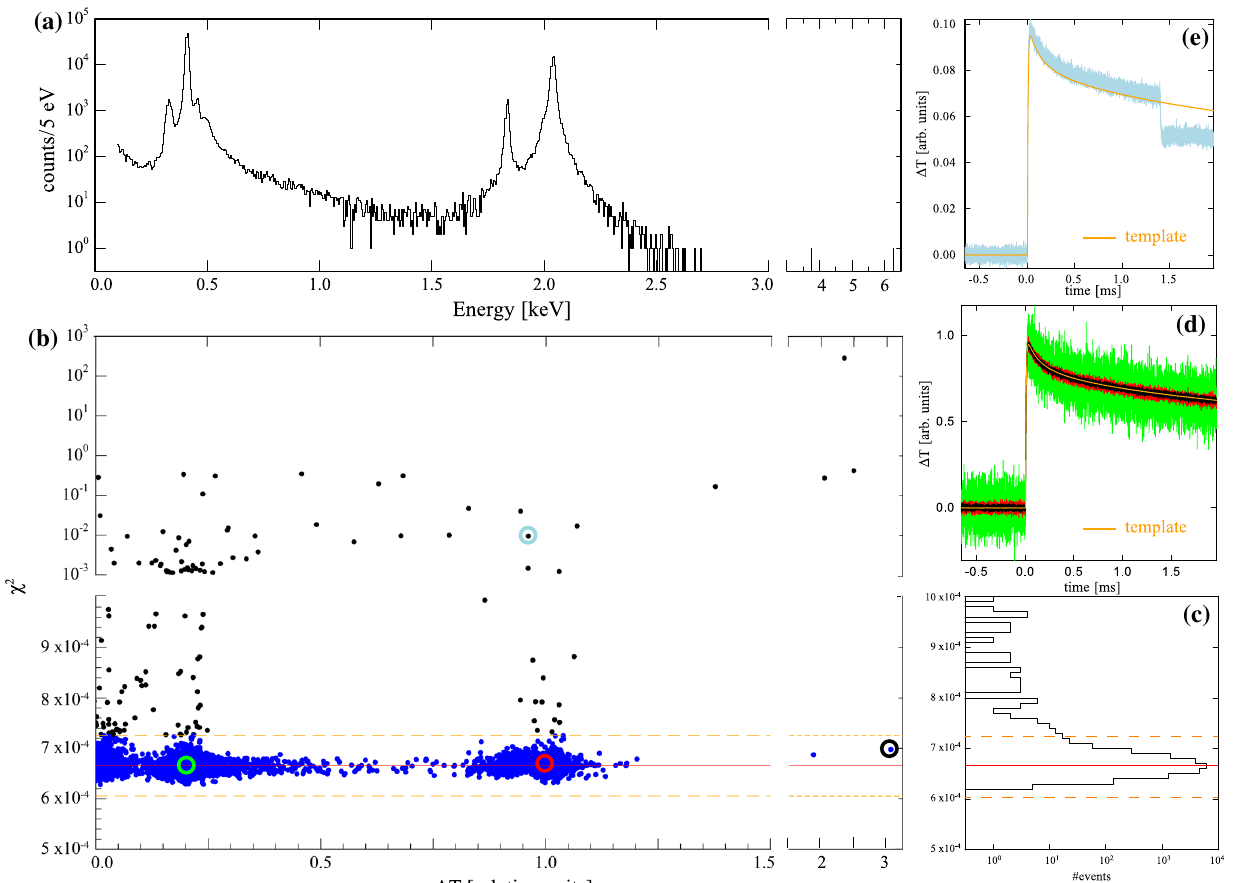
Fig. 1 a Energy spectrum of the 163 Ho decay. b χ 2 -value of the tem- plate fit versus the relative temperature change of the pulses. c His- togram of the χ 2 -values for the corresponding range in b . d 3 time traces with different absolute amplitudes and the used template scaled